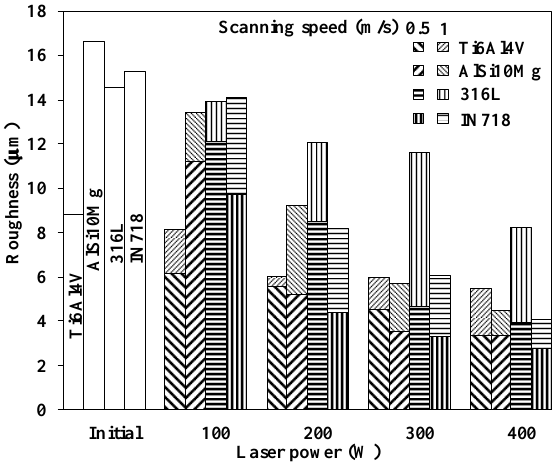
Figure 9. Relationship between laser power, scanning speed and roughness.